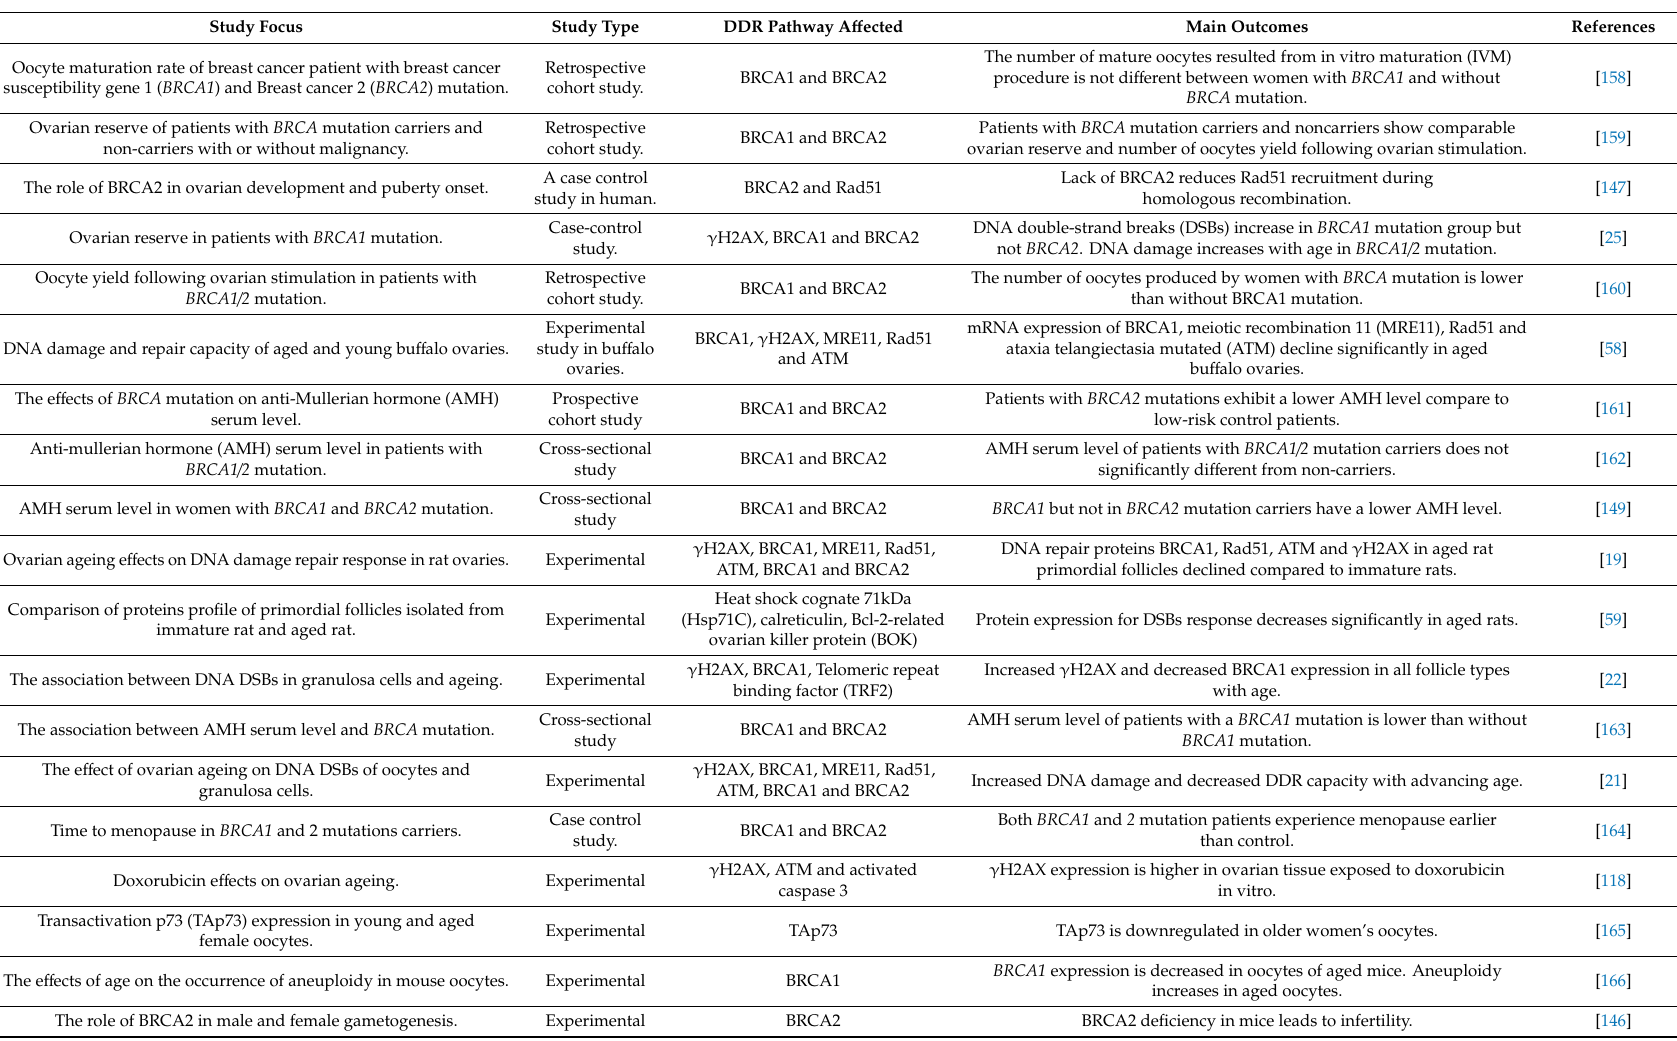
Table 2. Summary of recent clinical and experimental studies providing evidence linking DNA damage response (DDR), ovarian ageing and ovarian